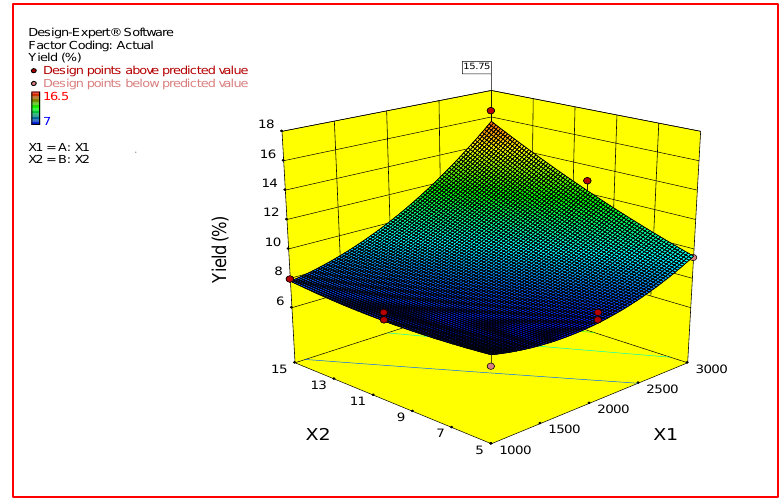
Figure 1. Response surface plot showing the effect of centrifugal speed and centrifugal time on the potato starch yield (%).